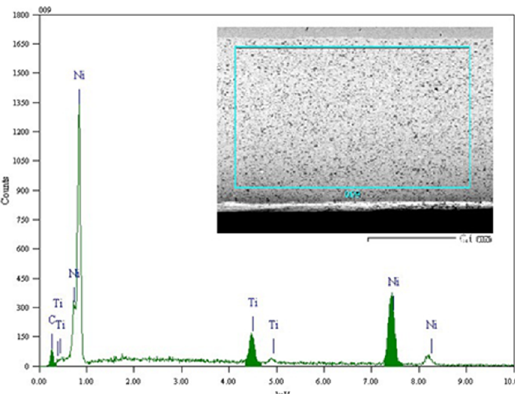
Figure 3. EDS spectra of Ni-TiC composite coatings